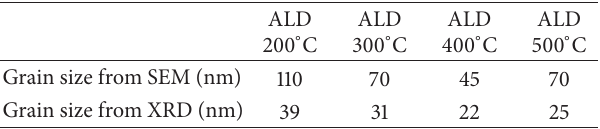
thin films by SEM and